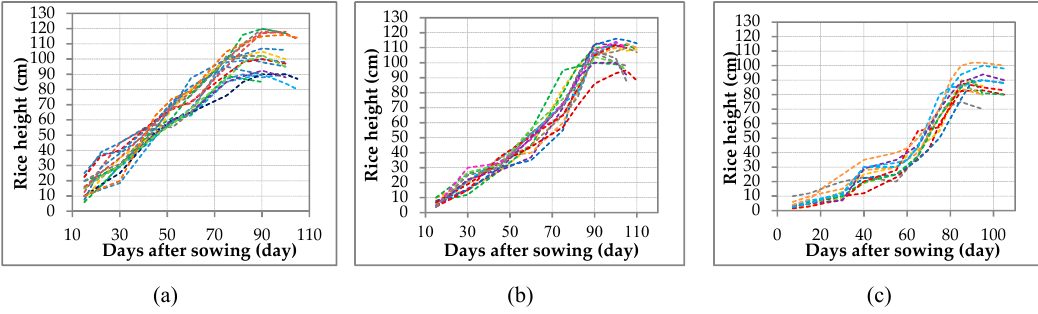
Figure 4. Temporal changes in rice height at 43 locations for different growth stages: ( a ) triple-rice crop, ( b ) double-rice crop, and ( c ) single-rice crop.